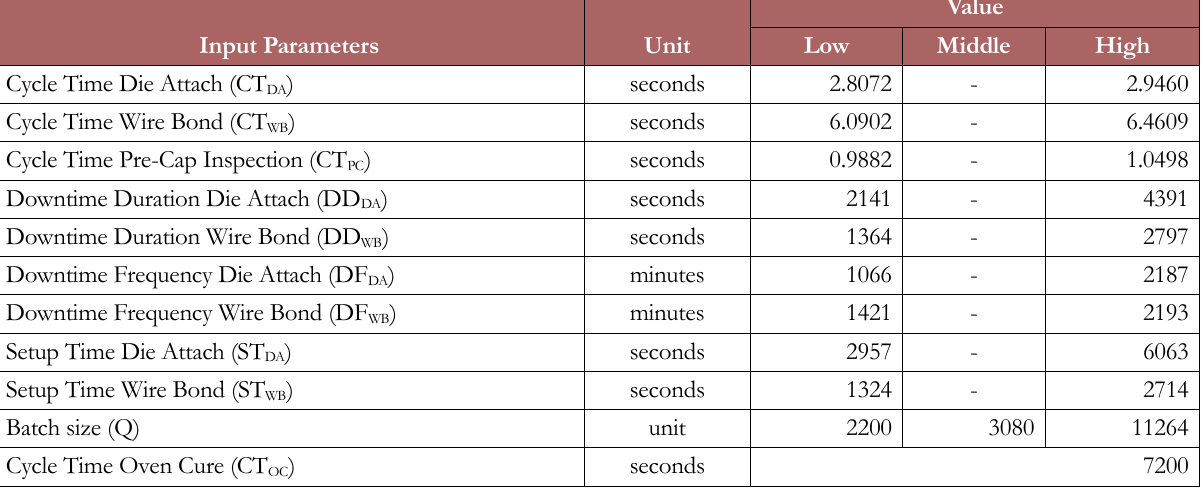
Table 1. Values of Process Parameters